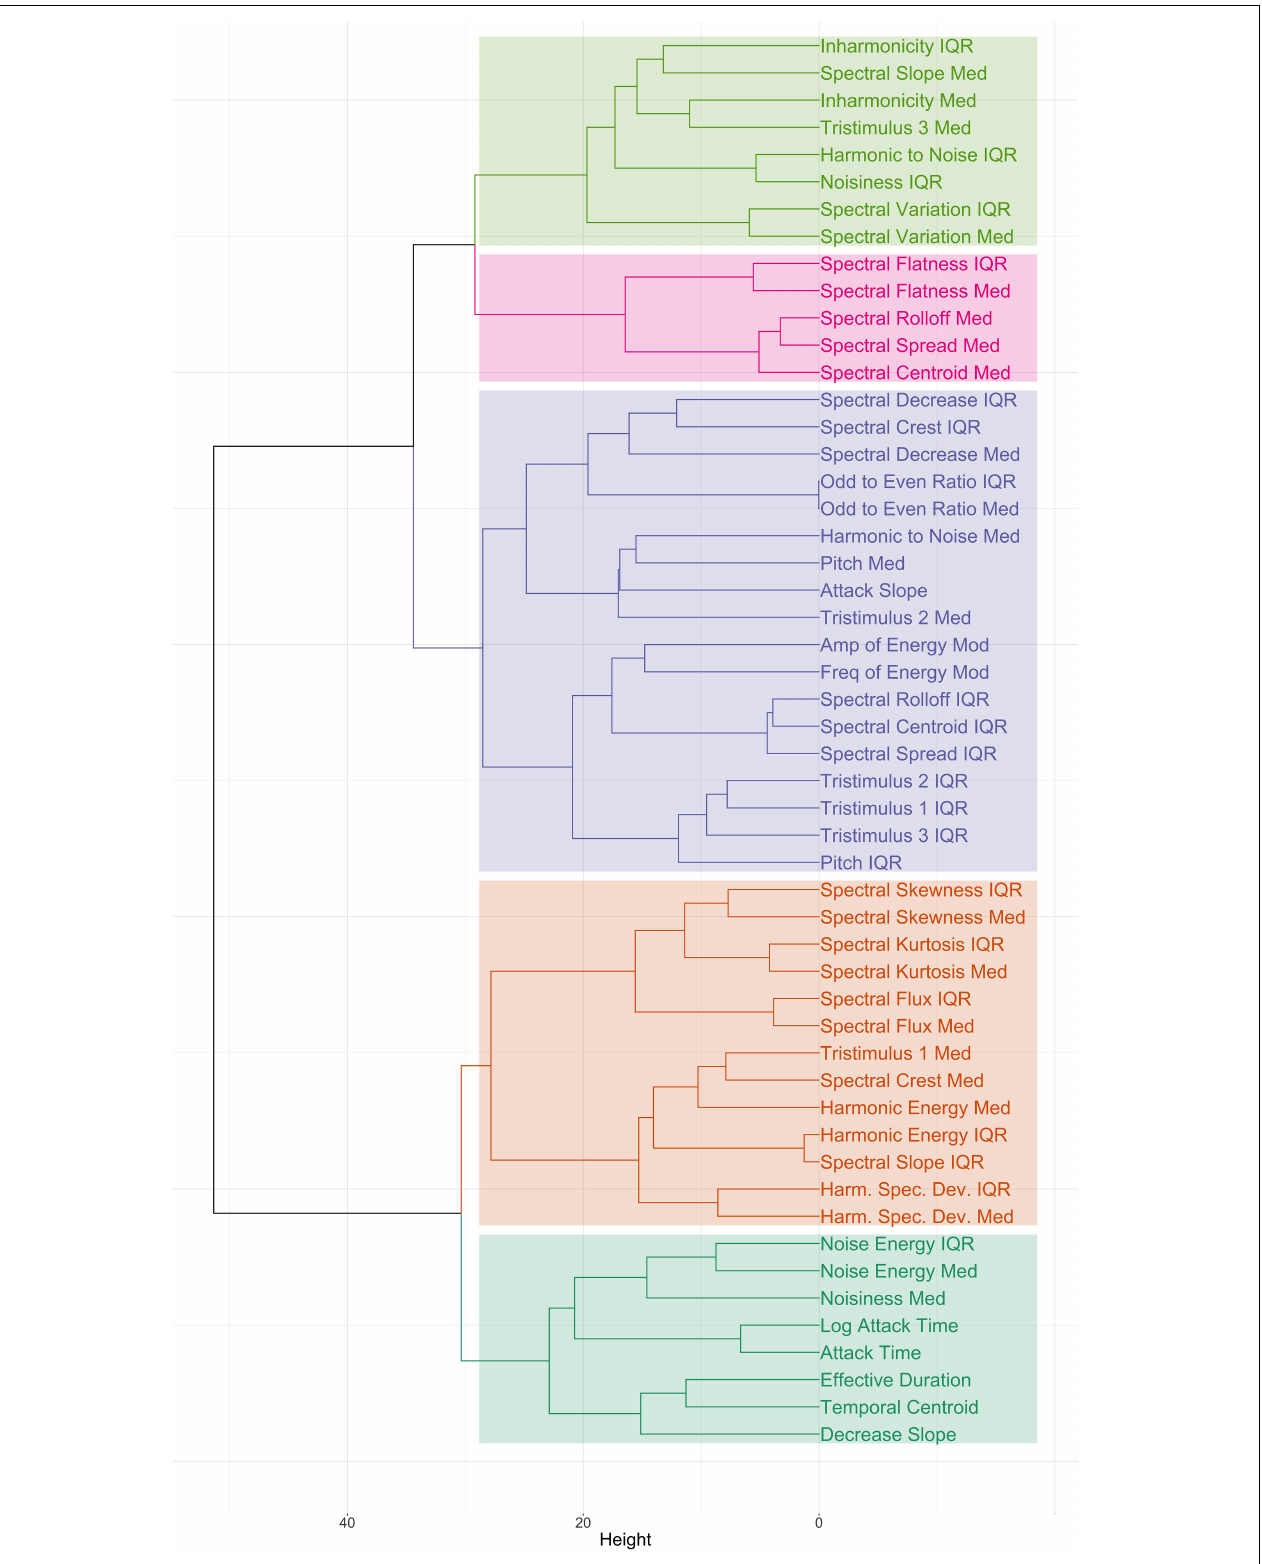
FIGURE 4 | Dendrogram of hierarchical clustering of feature values across the stimulus set. Colors indicate groups of features organized by a five-cluster solution.